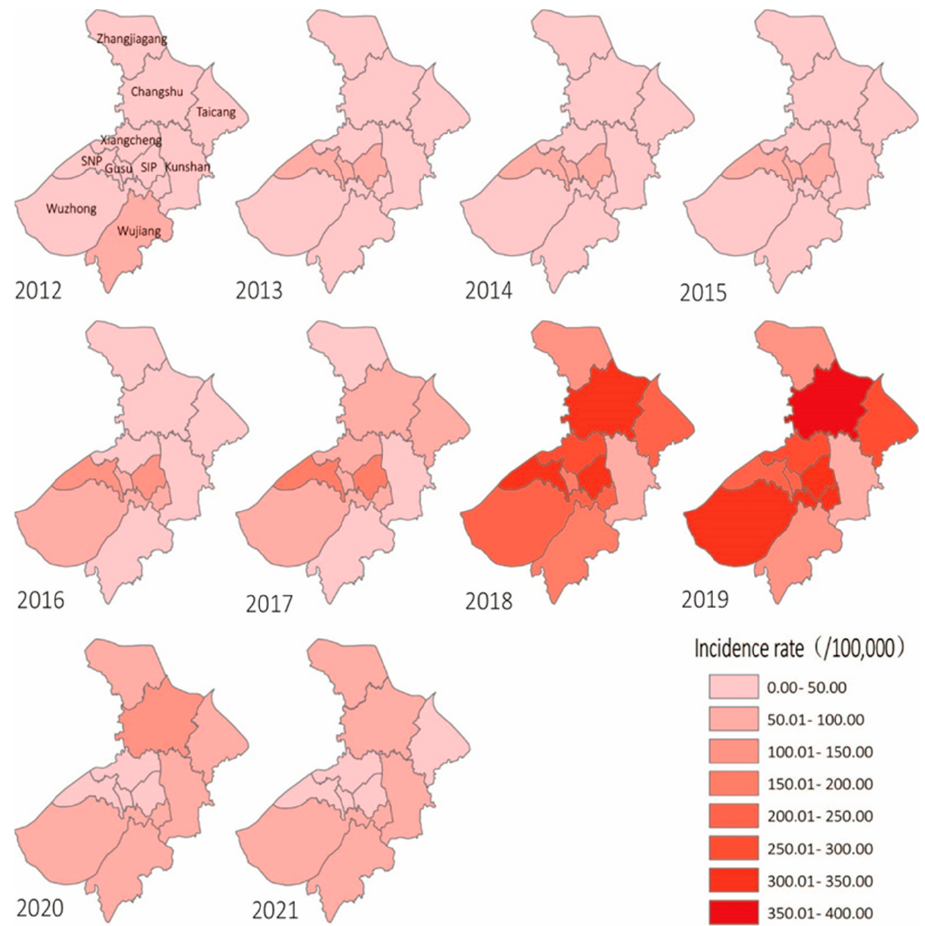
Figure 2. The district distribution of incidence rates in Suzhou, 2012–2021. From 2012 to 2021, the top three average annual incidences in Suzhou occurred in Suzhou Industrial Park (SIP) (118.28/100,000), Changshu (113.29/100,000) and Suzhou national Hi-tech District (SND) (117.01/100,000). The highest incidences in 2012, 2013, 2014–2017, and 2018–2021 occurred in Wuzhong (69.95/100,000), SIP (63.05/100,000), SND (150.10/100,000), and Changshu (229.81/100,000), in that order. After implementing two-dose vaccination, the number of cases in each district decreased by approximately 46.94% compared with the one-dose vaccination schedule. The top three districts and cities with a notable decrease were SIP (69.64%), Gusu (60.51%) and SNP (59.59%).